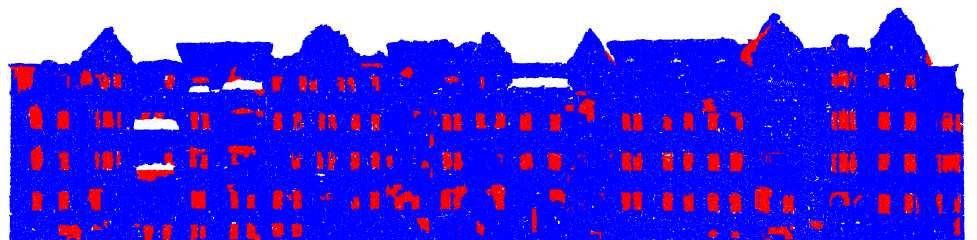
Figure 6. Window extraction result. Red segments refer to windows